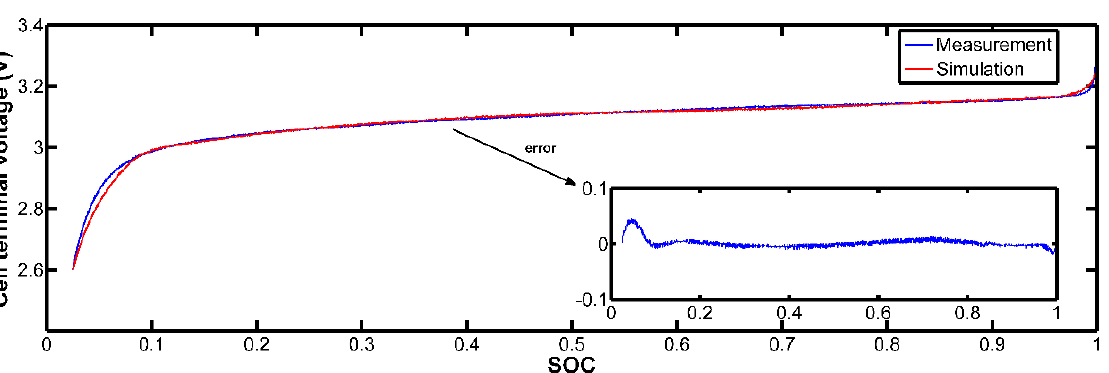
Figure 2. Measured voltage and simulated voltage for a fully charged new